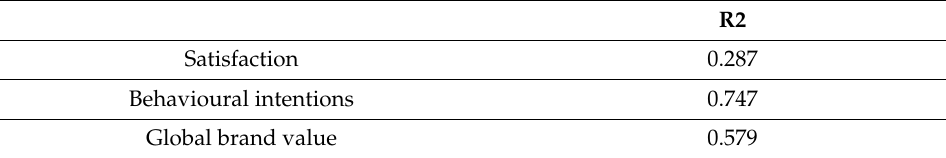
Table 8. R2 of the structural model.